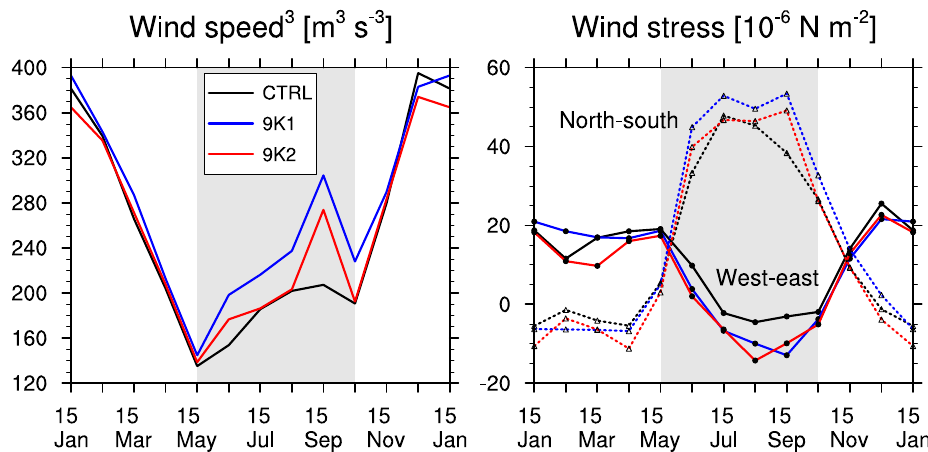
Fig. 13. Monthly climatology of wind components averaged over the Aegean/West Levantine regions for CTRL (black), 9K1 (blue) and 9K2 (red). Left panel shows 10-m wind speed cubed, the cubed value is considered because it is proportional to mixing strength. Right panel shows both west-east and north-south wind stress components. The shading represents the time period, when modelled Etesian winds are active.